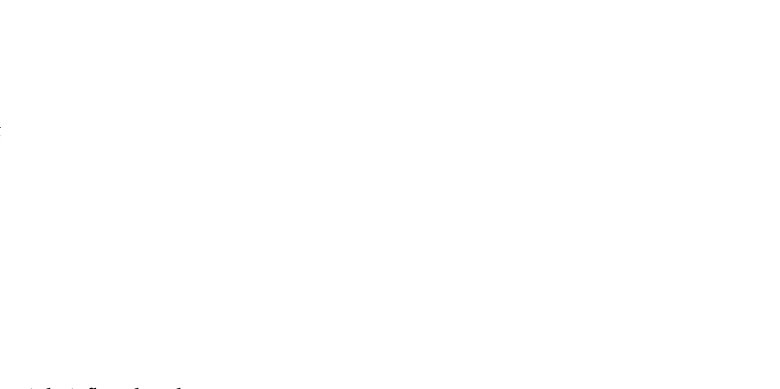
Table 1. Various protocols of calcination and pyrolytic/sintering treatment of beads. Code